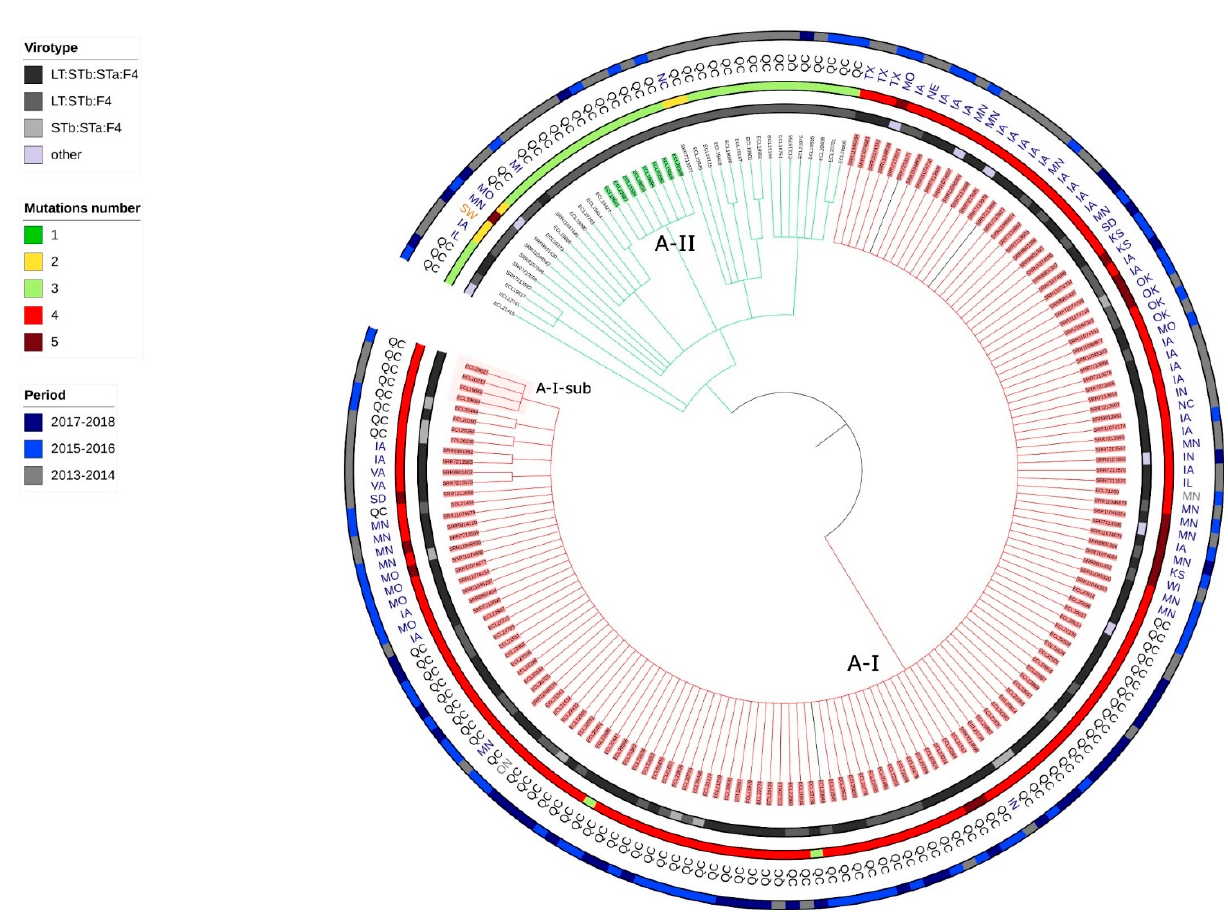
Figure 2. Circular Tree based on SNP phylogeny. The length of the branches is not proportionate to the phylogenetic distance. All isolates belong to the clonal lineage A (ST100-O149H10-phylogroupA-no fimH gene) and originated from 2013 or after. Each branch with a bootstrap value under 1 was collapsed. QC = Quebec, SW = Switzerland, MN (in grey) = Manitoba, ON = Ontario, MI = Michigan, MN (in blue) = Minnesota. MO = Missouri, NC = North Carolina, TX = Texas, IA = Iowa, KS = Kansas, WI = Wisconsin, IN = Indiana, IL = Illinois, OK = Oklahoma, NE = Nebraska, SD = South Dakota, VA = Virginia. A-I and A-II designate each clone and A-I-sub designates the subclone within the clone A-I. The 3 isolates colored in black are the three outsiders (more than 70 SNPs of differences in the pairwise distance comparison). The identification name for each isolate belonging to a clone is highlighted in a specific color.